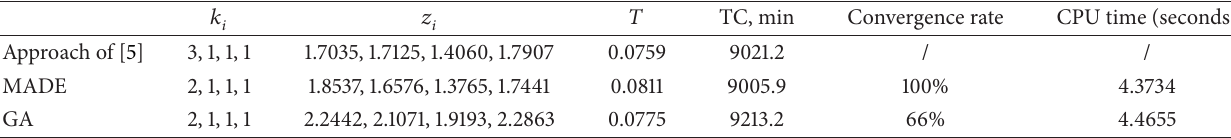
Table 4: Results comparison of three